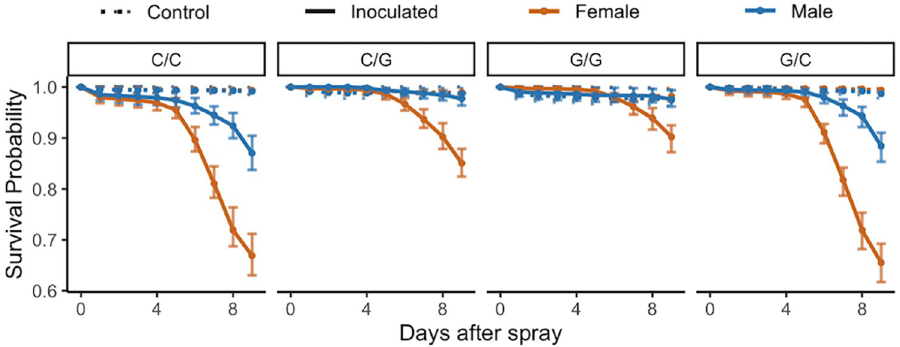
Fig 4. Effects of diet on post-inoculation survival of D . melanogaster inoculated with B . bassiana strain GHA (Experiment 3). Inoculated flies (Solid lines) had an overall lower survival than control flies (Dashed lines) under all dietary conditions (pre/post): cornmeal/cornmeal (C/C), cornmeal/glucose (C/G), glucose/glucose (G/G), and glucose/ cornmeal (G/C). There was no sexual dimorphism observed among control flies, but among inoculated flies males (blue) survived better than females (orange). The timing of introduction of a glucose diet affected post inoculation survival. For statistical analysis of these data see S4 and S5 Tables. The figure shows model estimates with 95% Bootstrap confidence intervals from the raw data shown in S9